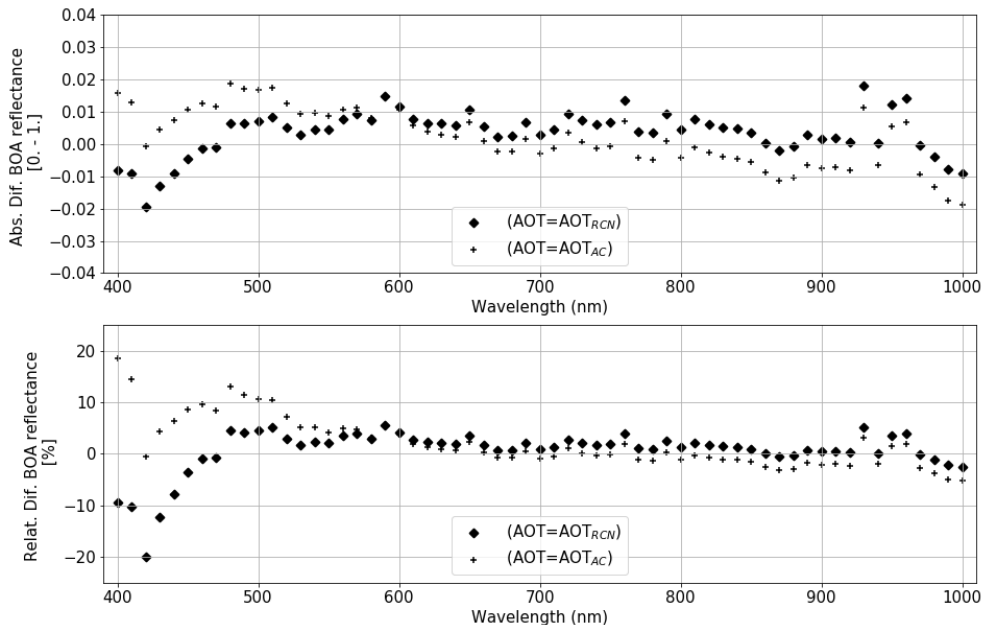
Figure 27. DESIS absolute ( top ) and relative ( bottom ) difference in BOA surface reflectance with RadCalNet reference data at Gobabeb site (4 February